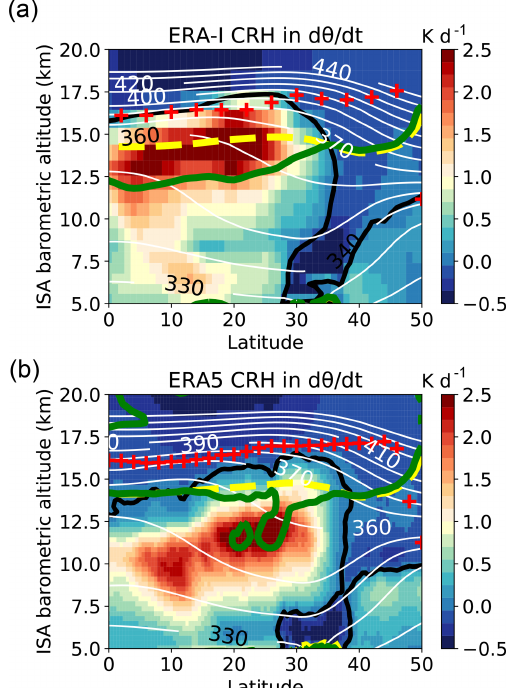
Figure 1. Cloud radiative heating (CRH) contribution to d θ/ d t (in Kd − 1 ) averaged over July–August 2017 in the 73–97 ◦ E longitude range. (a) ERA-Interim. (b) ERA5. The black contour shows the zero line of CRH. White contours show potential temperature (in K). Red crosses show the cold-point tropopause. The yellow line shows the clear-sky LZRH. The green contour shows the all-sky LZRH. The small green contour by 20km above the Equator in ERA5 (masking the yellow line beneath) is associated with a weak descent in this region. The vertical axis is the barometric altitude de- rived from pressure using the hydrostatic equation and the standard atmosphere. The true geopotential altitude is higher – up to + 850m on the 360K surface near 30 ◦ N (see Fig. S1 of the